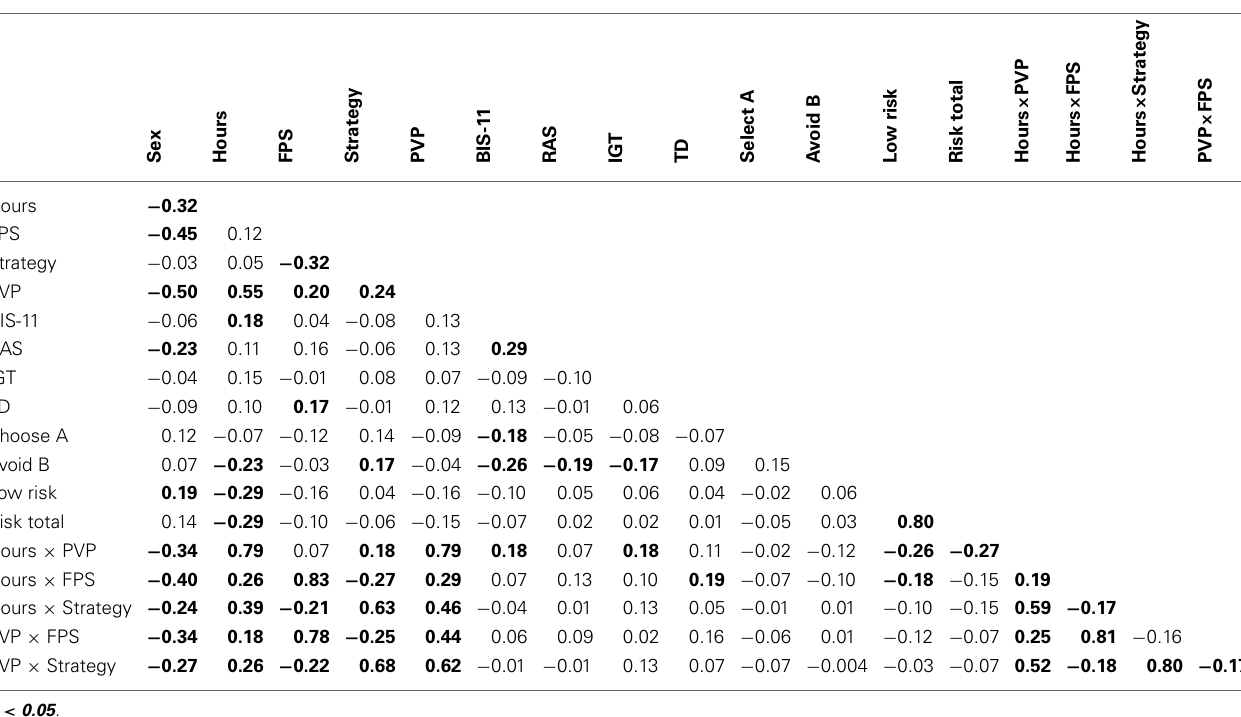
Table 2 | Correlations between all variables and interaction terms.